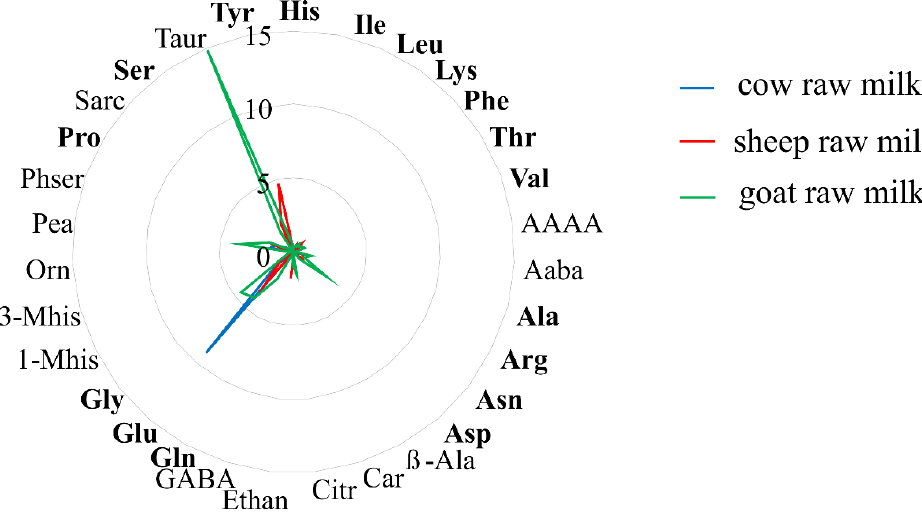
Figure 5. Radar graph of the average free amino acid profile from cow, sheep and goat raw milk analyzed samples.